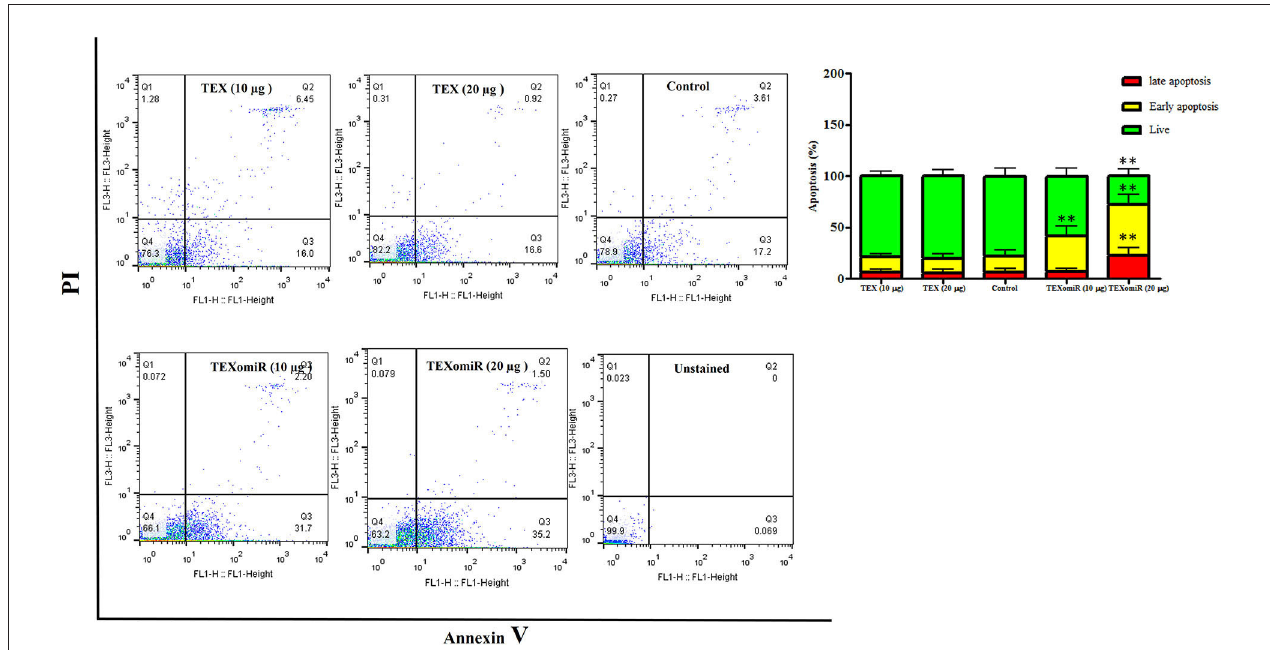
FIGURE 5 | The effect of TEXomiR on cell apoptosis. TEX had no significant effects on the apoptosis of CT-26 cells. Following treatment with TEXomiR, the apoptosis percentage of CT-26 cells significantly increased. The data are representative of three independent experiments presented as mean ± SD. ** P < 0.01. One-way ANOVA was used to make comparisons between groups.